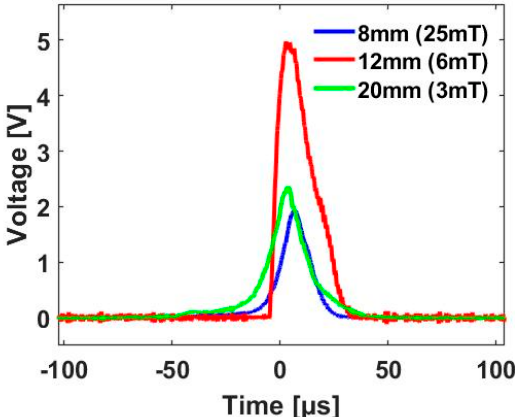
Figure 2. Voltage pulses at distances of 8, 12, and 20 mm corresponding to magnetic field intensities ( µ 0 H ) of 25, 6, and 3 mT.